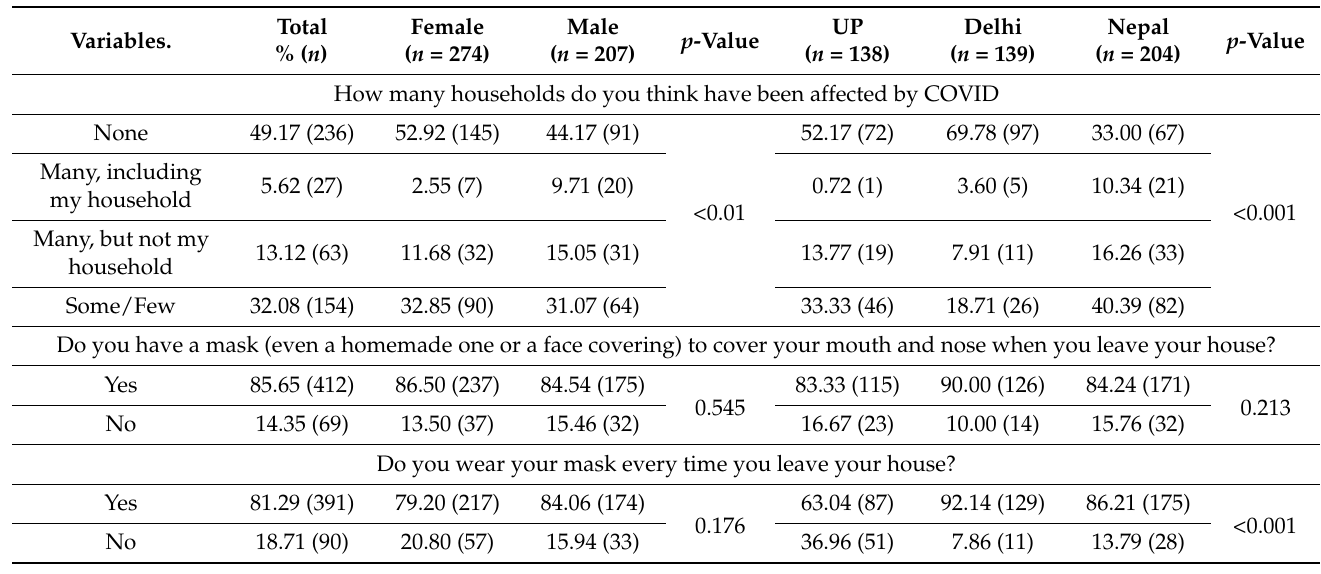
Table 3. Household perceptions and risk reduction